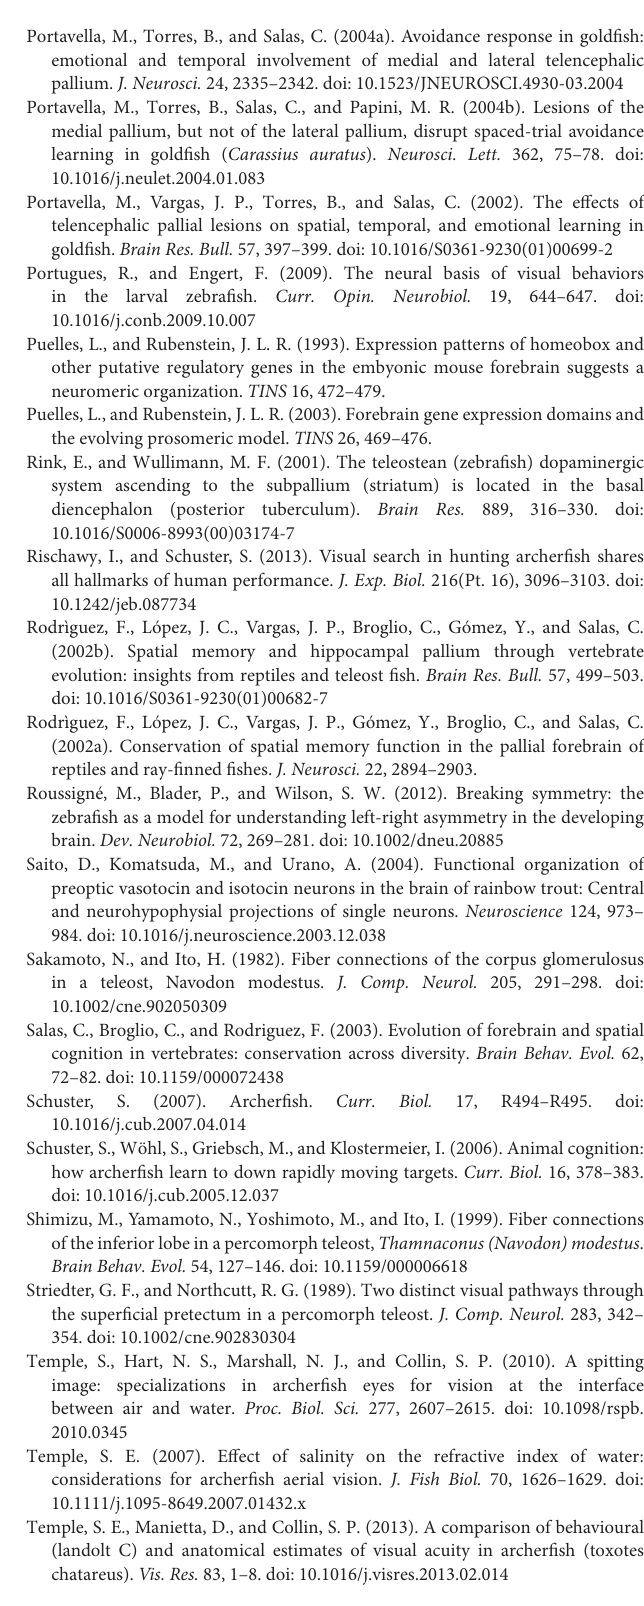
Frontiers in Neuroanatomy |